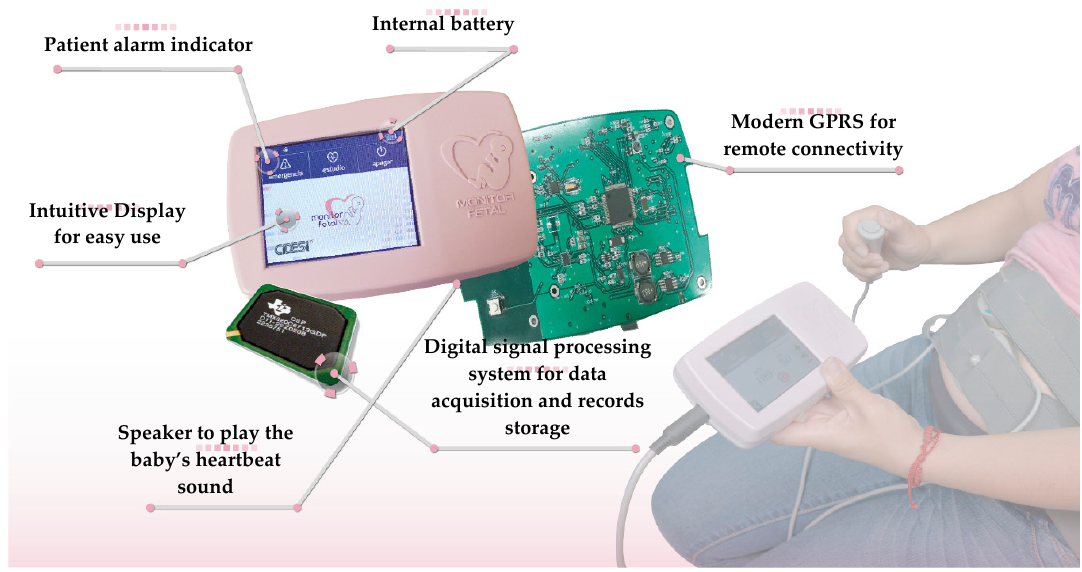
Figure 6. Scheme of the fetal monitor used for testing.